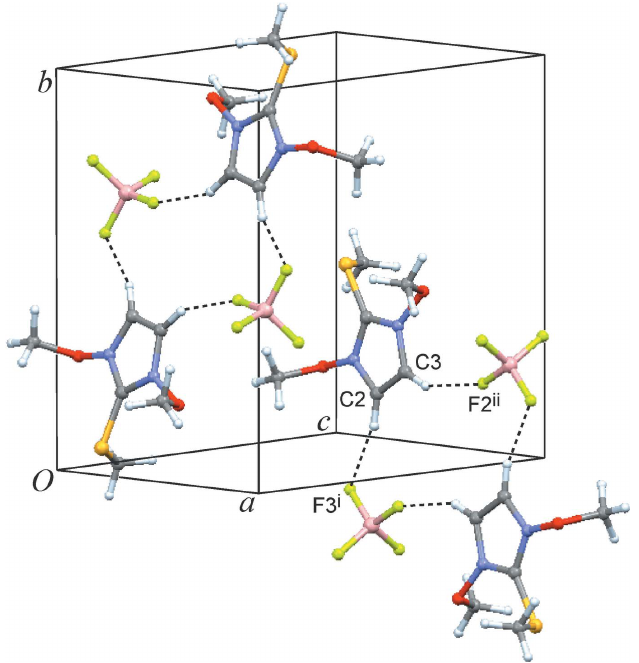
Figure 4 Crystal packing of compound 1 . Dashed lines represent the shortest ; (ii) x + 1 , (cid:3) y + 1 , z + 1 .] 2 2 2 2